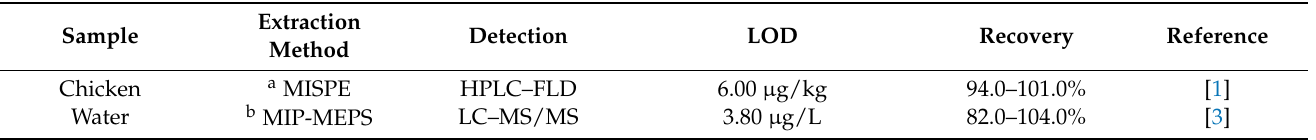
Table 1. Comparison of the methods for the determination of norfloxacin.